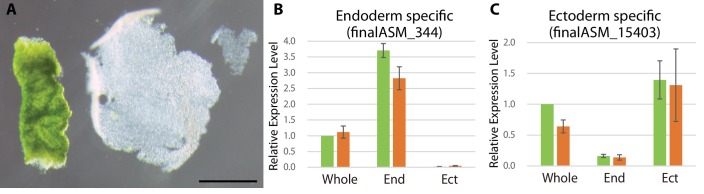
Tissue isolation of green hydra.(A) Isolated endoderm (left) and isolated ectoderm (right). Scale bar, 1 mm. Expression levels of an endoderm-specific gene finalASM_15403 (B) and that of an ectoderm specific gene finalASM_344 (C) in whole hydra (Whole) and isolated endoderm (End) and ectoderm (Ect) were examined to confirm whether tissue isolation had performed properly. For each biological replicate (n = 3) 10–20 hydra polyps were used for total RNA extraction of endodermal and ectodermal tissue. Error bars indicate standard deviation.